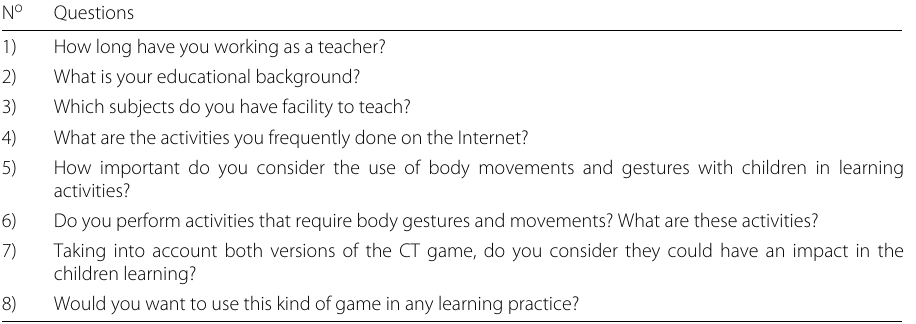
Table 4 Questions applied in the